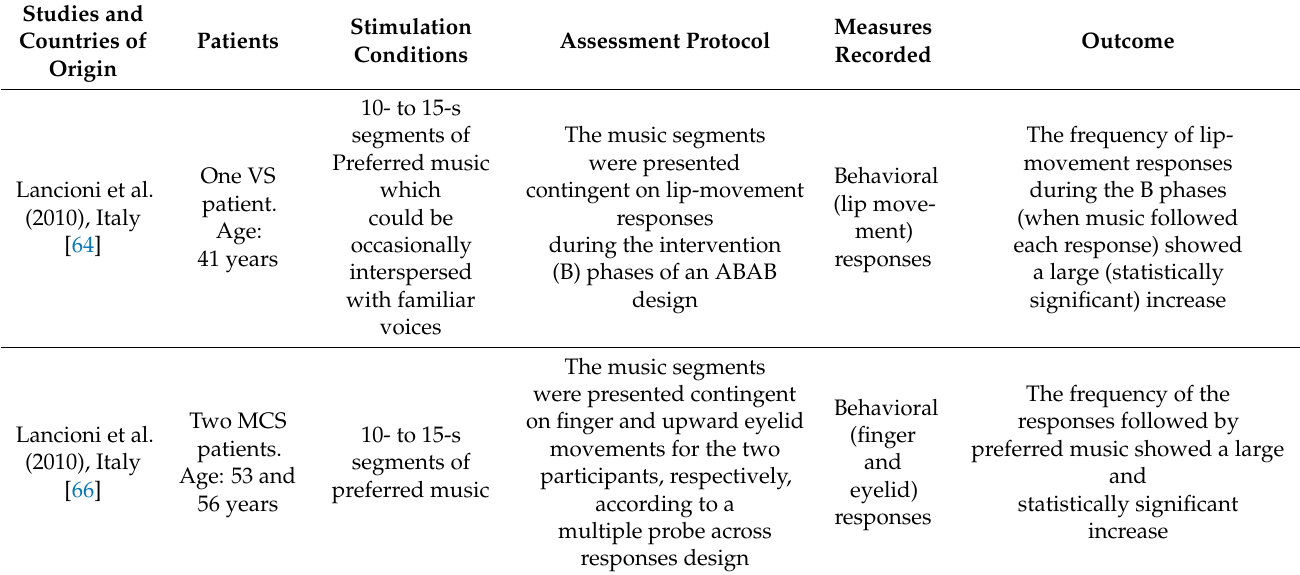
Table 3. Studies Assessing the Impact of Response-contingent